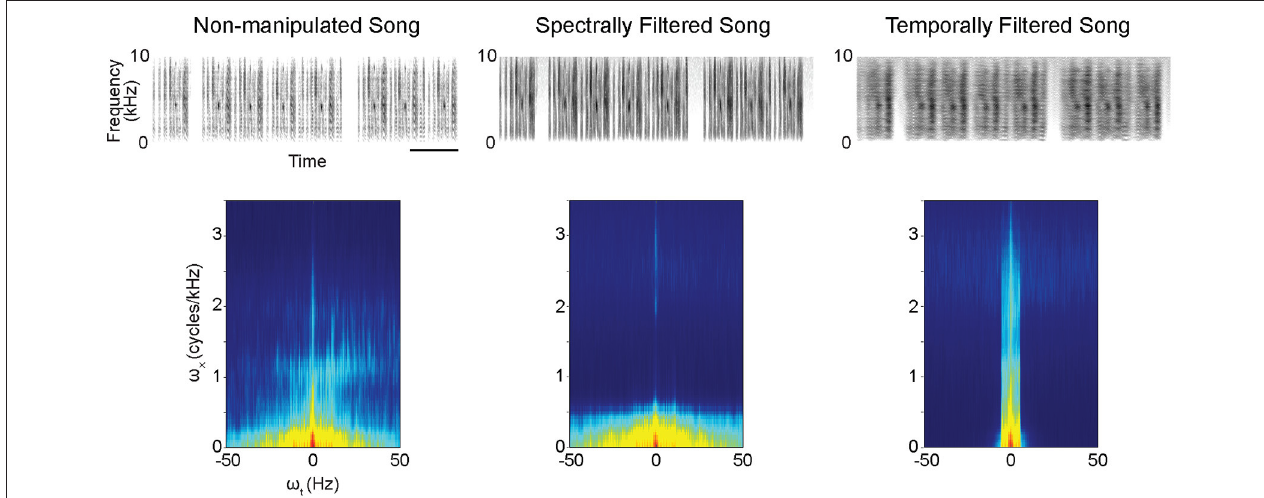
FIGURE 1 | Example spectrograms (excerpts from original 16-s stimuli) (Top) and modulation power spectra (Bottom) for the different stimulus types. The modulation power spectra quantify the spectro-temporal structure present in the sounds. Filtering to reduce spectral or temporal information from the songs was performed on these modulation power spectra. ω x = spectral modulations, ω t = temporal modulations. scale bar = 1s.